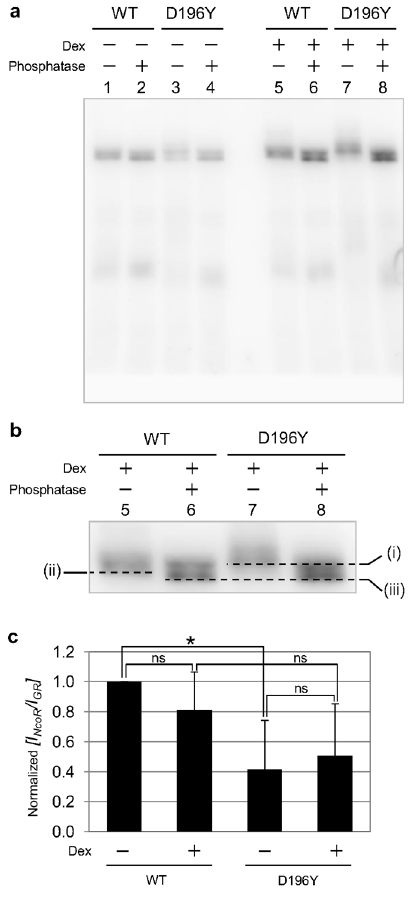
Figure 5. The differences between the hGR wild type and D196Y mutant for phosphorylation state and binding to NCoR. ( a ) Phos-tag PAGE for phosphorylation of EGFP-hGR WT and EGFP-hGR D196Y . In the absence of Dex (lane 1–4), any differences in the band-shifts were not observed; ( b ) the enlarged image of lane 5–8 of ( a ) after stimulation with Dex. The band of EGFP-hGR WT (from lane 5 to 6) and EGFP-hGR D196Y (from lane 7 to 8) was shifted by the addition of the phosphatase. However, the band shift caused by the dephosphorylation of EGFP-hGR D196Y , corresponding to the shift from (i) to (iii), was greater than that of EGFP-hGR WT , corresponding the shift from (ii) to (iii); ( c ) binding of NCoR with hGR wild type and D196Y mutant was analyzed by coimmunoprecipitation. The tendencies of binding NCoR with the hGR wild type and D196Y mutant were shown as normalized to the relative intensity [I NCoR /I GR ] of the bands quantified from Figure S5a,b. The mean and SD of normalized relative intensity [I NCoR /I GR ] was obtained from three individual experiments. *: p < 0.05, ns: no significant differences. (Student t -test).